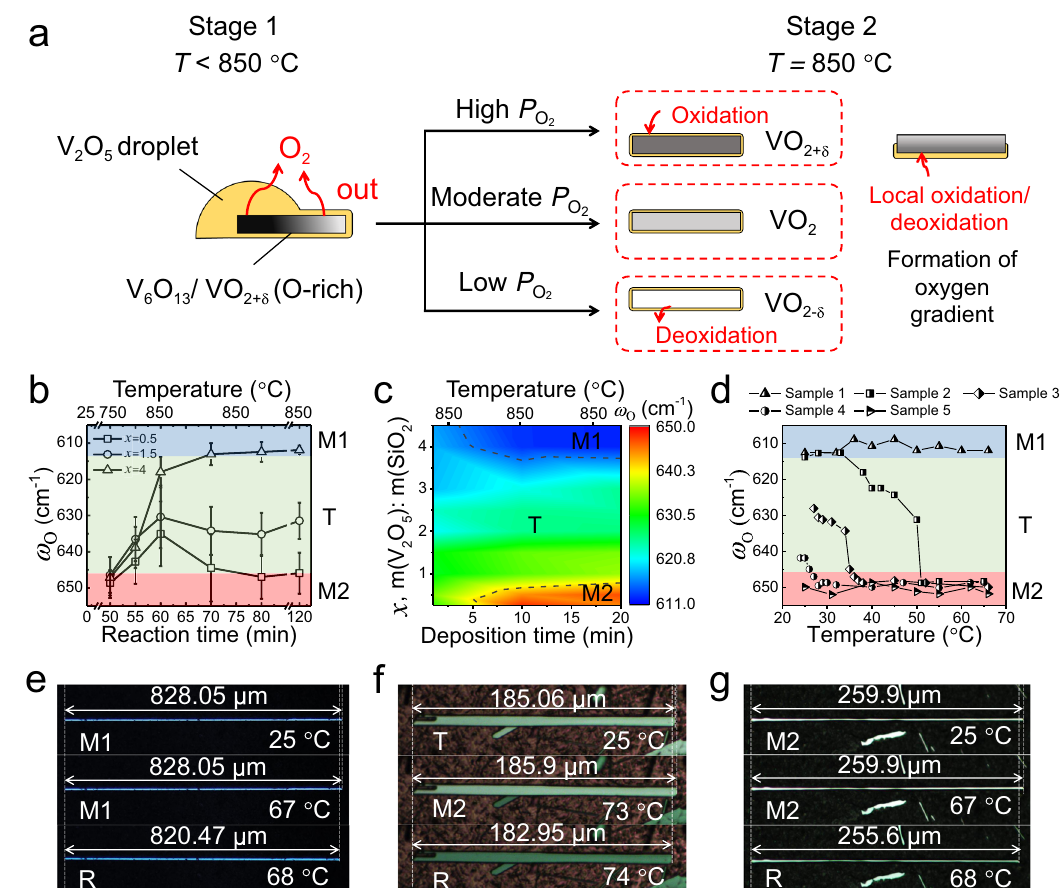
Fig. 2 Stoichiometry engineering of CVD-grown VO 2 crystals. a Schematics of CVD growth of VO 2 beams and their phase transformation under different oxygen partial pressures ( P O s). The reaction process occurs in two stages, stage 1 ( T < 850 °C) and stage 2 ( T = 850 °C). The yellow regions represent 2 the V 2 O 5 wetting layer. b Phase transformation of as-grown VO 2 beams during the typical CVD reaction versus x (the mass ratio of V 2 O 5 to SiO 2 ) and the error bars are the corresponding standard deviations, where the reaction time for the heating process is started at the temperature 25 °C. c Structural phase diagram of CVD-grown VO 2 beams prepared at 850 °C under different conditions, i.e., x and the deposition time (from the time when the reaction temperature hits 850 °C), which is represented with ω O frequency shift. d ω O frequency shift of the VO 2 beams with room temperature-stable M1, T, and M2 phases at increasing temperature, corresponded to routes 1 – 5 in Fig. 1b. Temperature-dependent optical images of each separated VO 2 beam with room temperature-stable e M1, f T, and g M2 phase upon